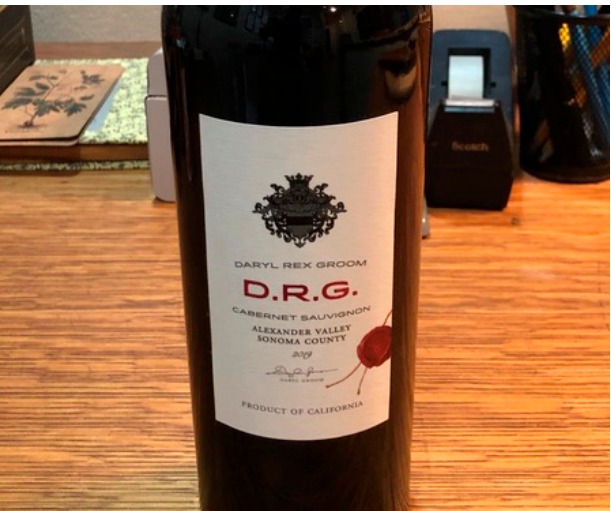
Figure 3. Bottle of wine with descriptive, factual information including the type of grape, where the grapes were grown, the year vinted and the name of the vintner. These attributes are visually evident on the label and convey surface meaning; essential facts about the wine (Photo by author).